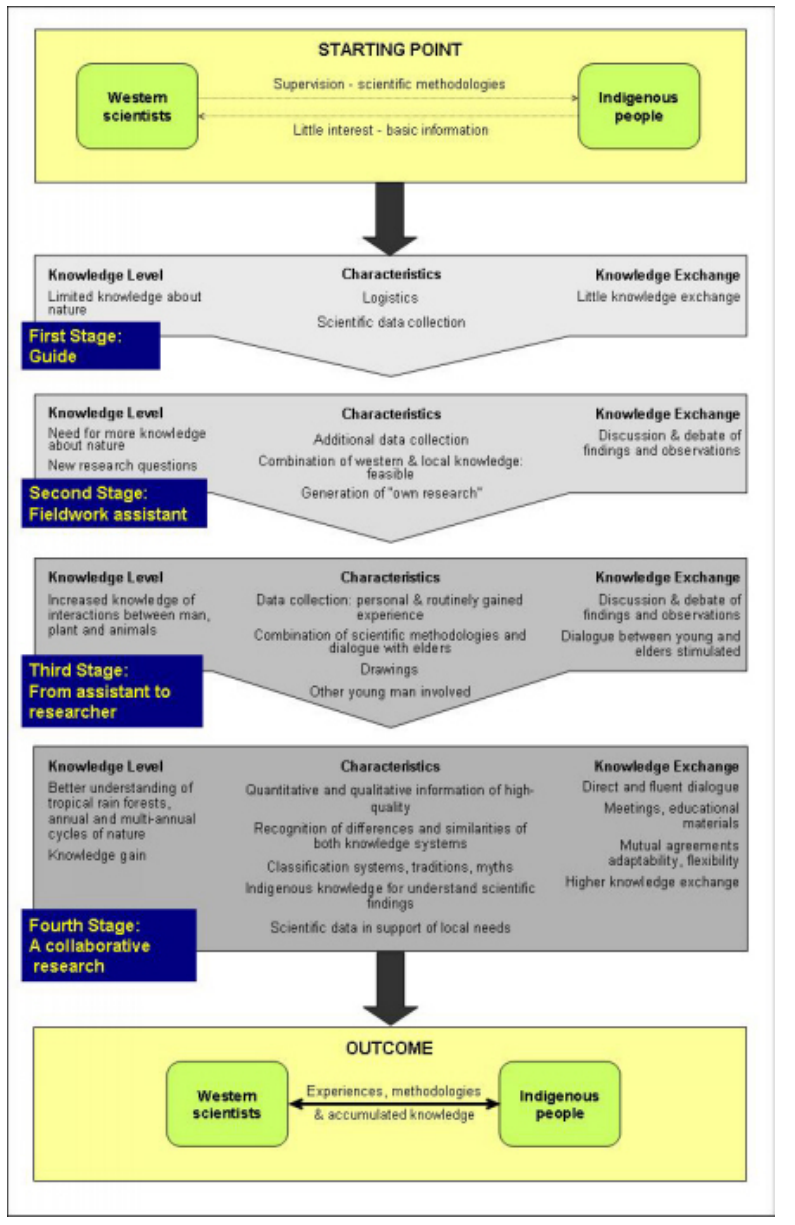
Fig. 2. Process for developing collaborative research between the Nonuya indigenous community and western scientists while studying fruit production patterns and the role of animals in the spatial distribution patterns of tree species. The starting point is a distant relationship between western scientists and indigenous people. From top to bottom the process consists on four main stages that indicate how this relationship with indigenous people, participating as passive guides, and little knowledge exchange developed into a collaborative-research relationship of high knowledge exchange. On the left side of the figure the sequence of knowledge gain. On the right side the increase of knowledge